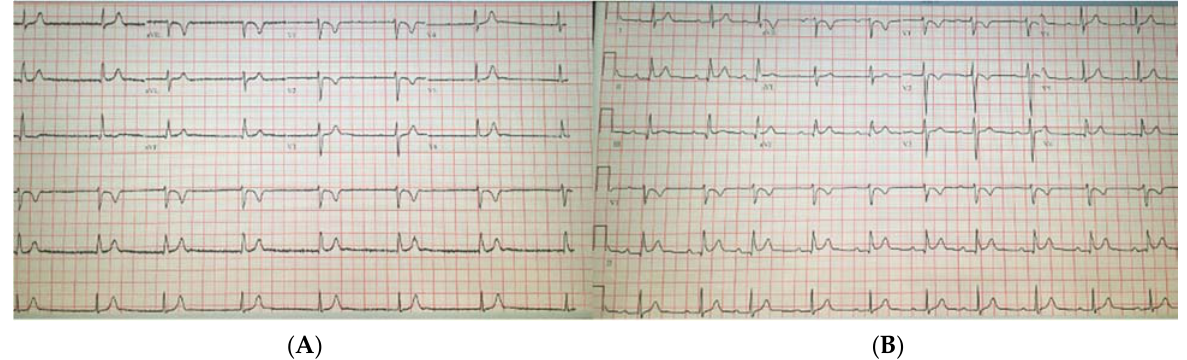
Figure 2. The ( A ) electrocardiogram at a rate of 45 beats per minute, and ( B ) electrocardiogram with junctional rhythm and resumption of normal sinus rhythm after theophylline.